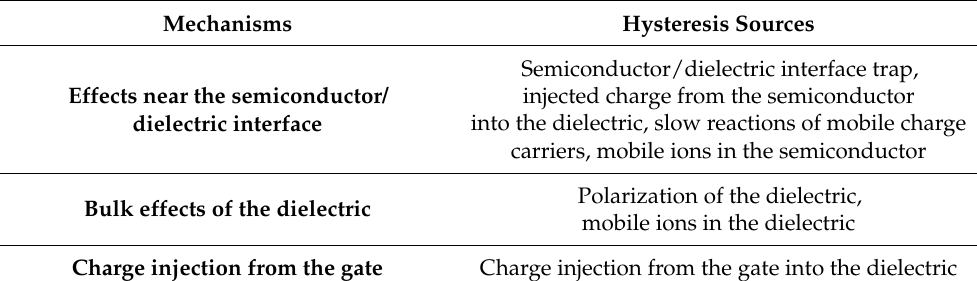
Table 1. Three typical hysteresis mechanisms and their sources